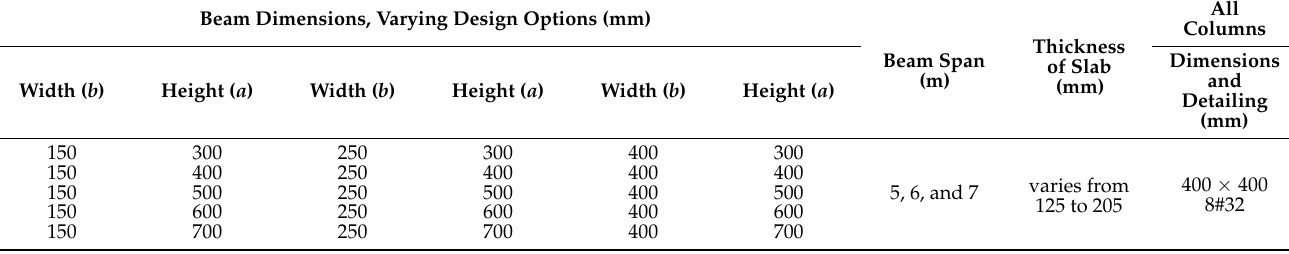
Table 1. The varying design options of the sub-assemblages.